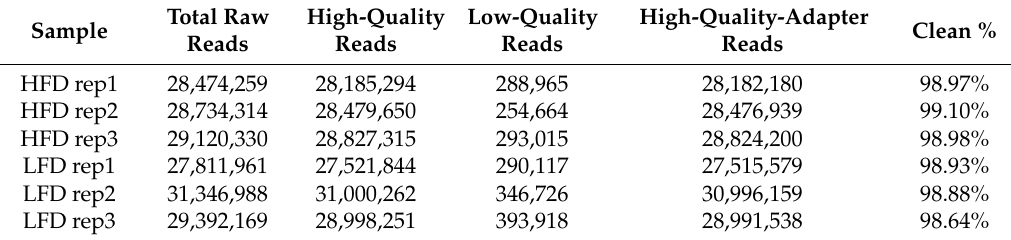
Table 1. Summary of RNA sequencing (RNA-Seq) data with adapter removal and quality trimming.